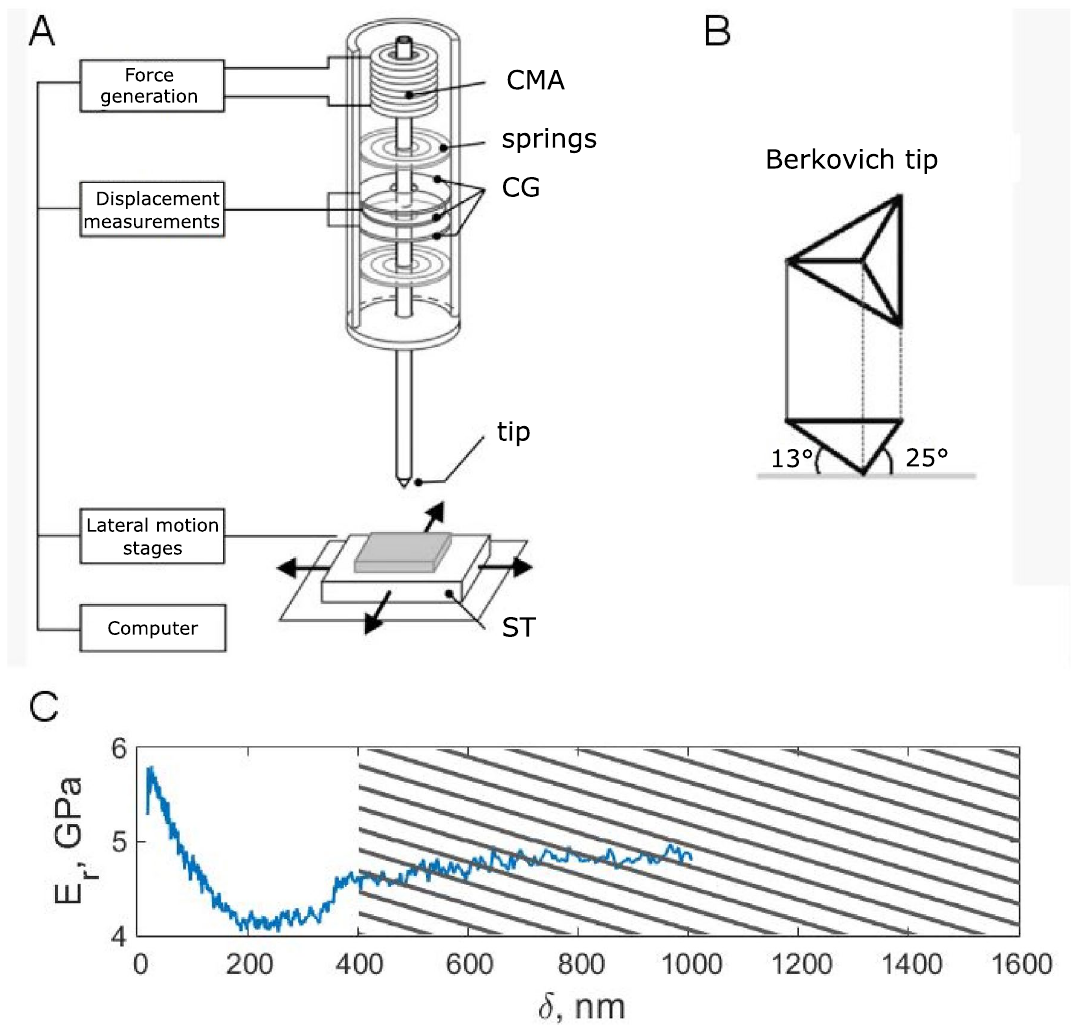
Figure 3. Nanoindentation experiments. ( A ) A scheme of the nanoindenter (adopted from Klein et al. 44 ). ( B ) Berkovich tip imprints on a feather sample after nanoindentation. ( C ) CSM measurement curve of Young’s modulus (E). The material parameters were averaged over the hatched area. CMA is a coil/magnet assembly, springs are supporting springs, CG is a capacitance gauge, tip is a Berkovich indentation tip, ST is a 2D moving/ positioning stage with a sample